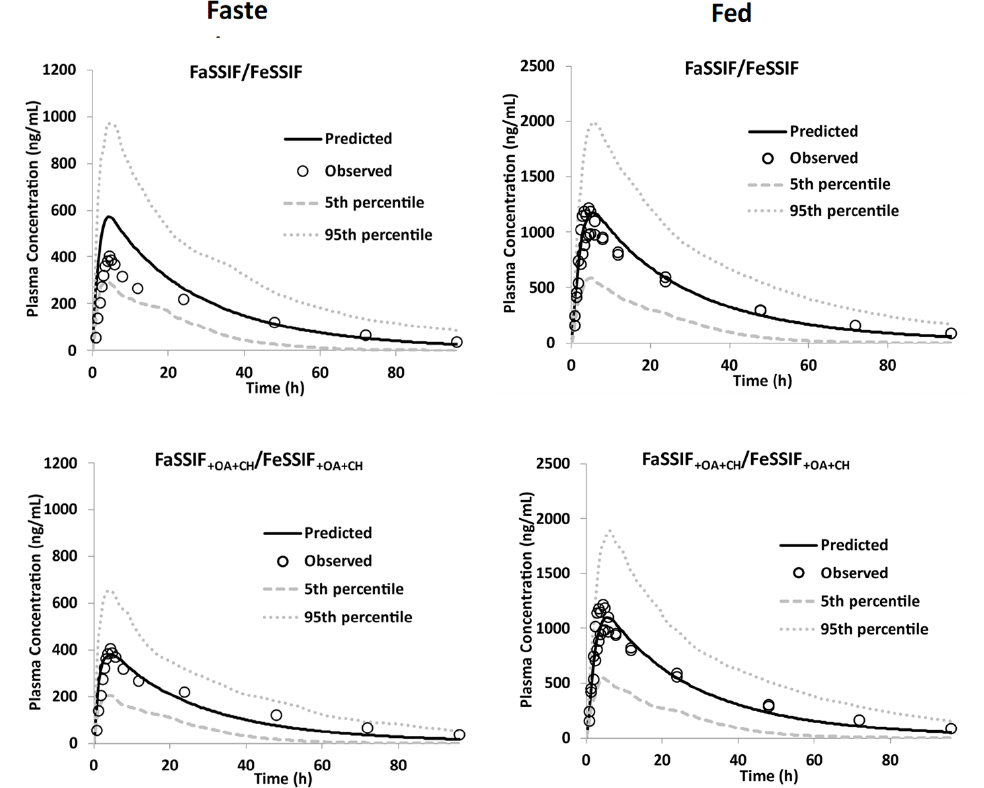
Figure 8. Performance verification (PV) of the PBBM model in fasted and fed states using the DLM model; overlay observed data from food effect study—200 mg (2 × 100 mg)—IR tablet—SD—after